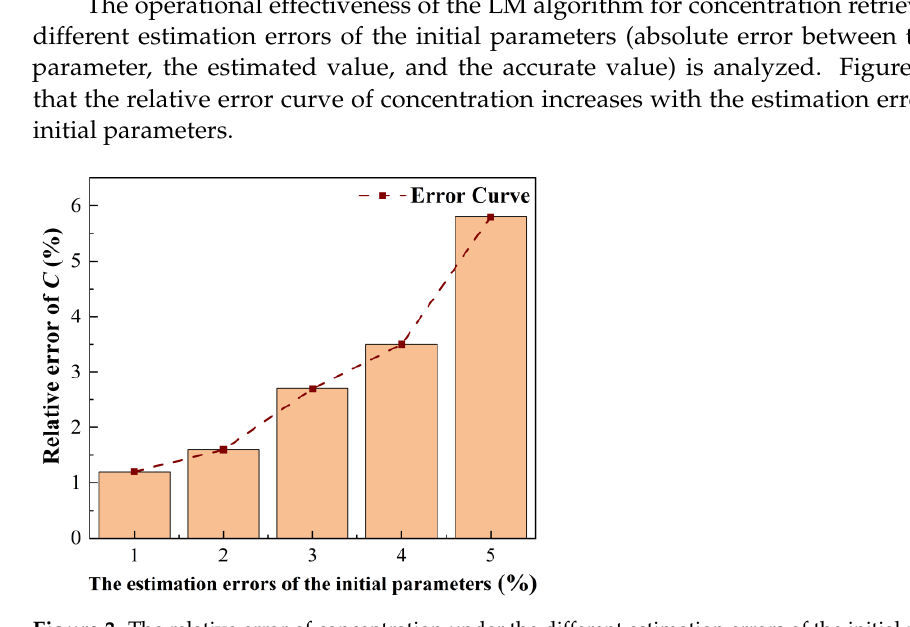
Figure 3. The relative error of concentration under the different estimation errors of the initial parameters.